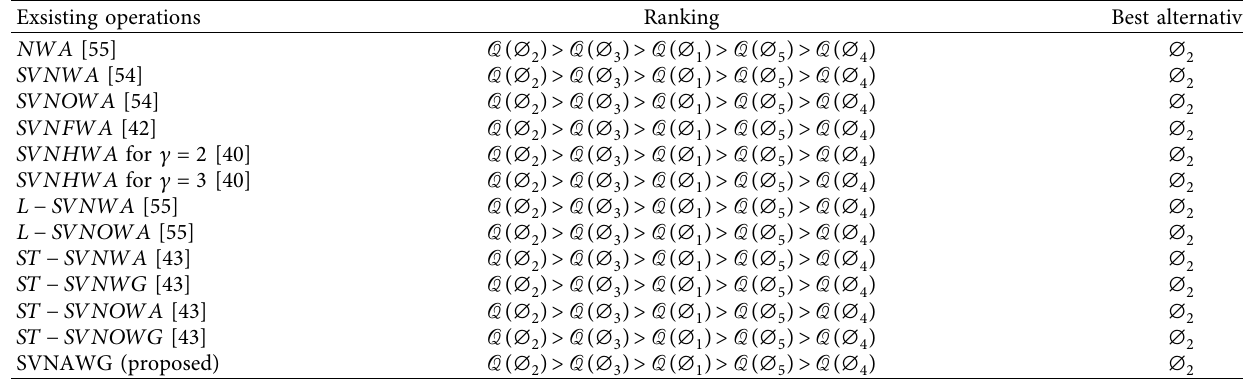
Table 10: Overall ranking of the alternatives.